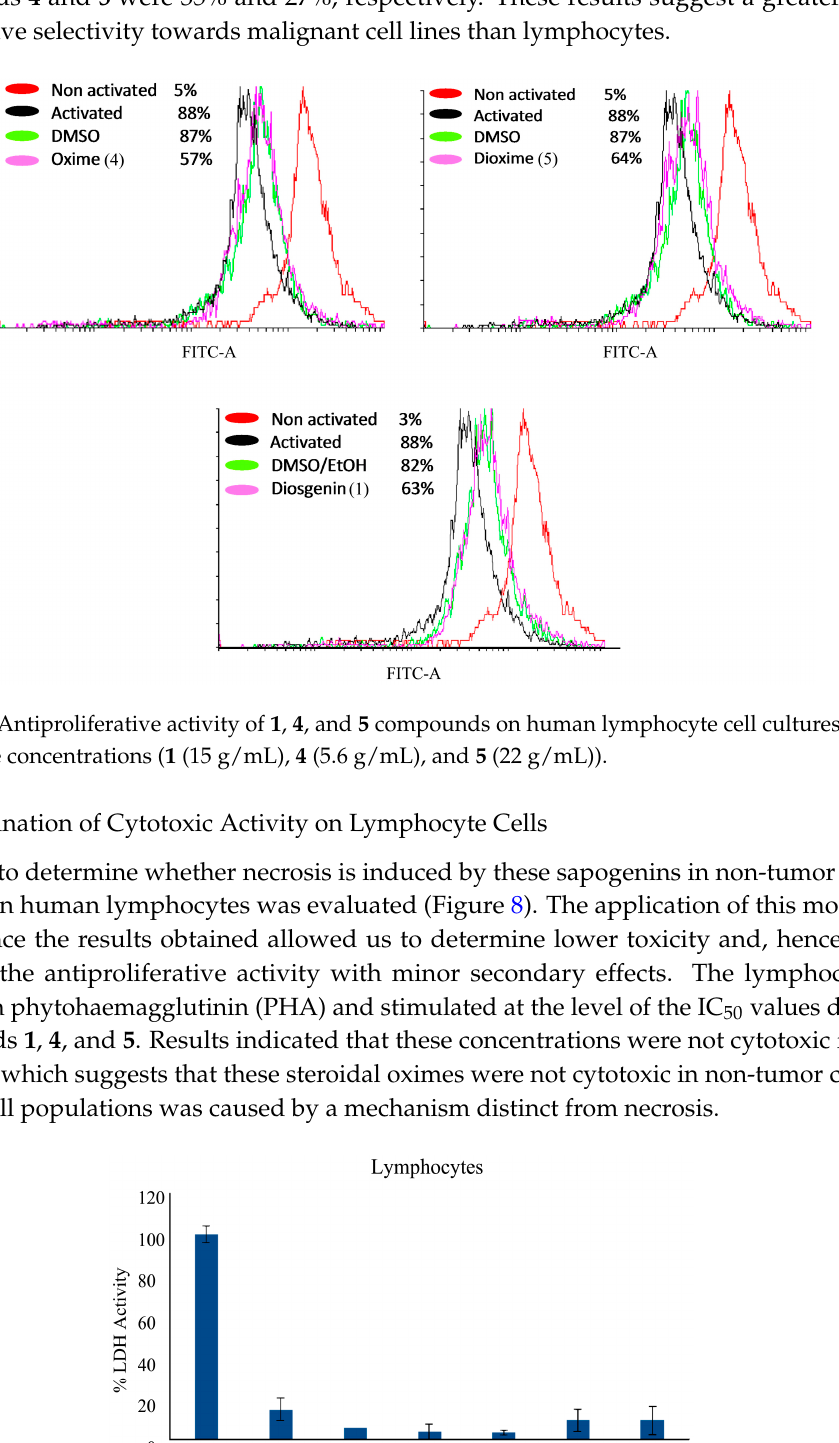
Figure 8. Evaluation of cytotoxicity for compounds 1 , 4, and 5 on human lymphocyte cell cultures.